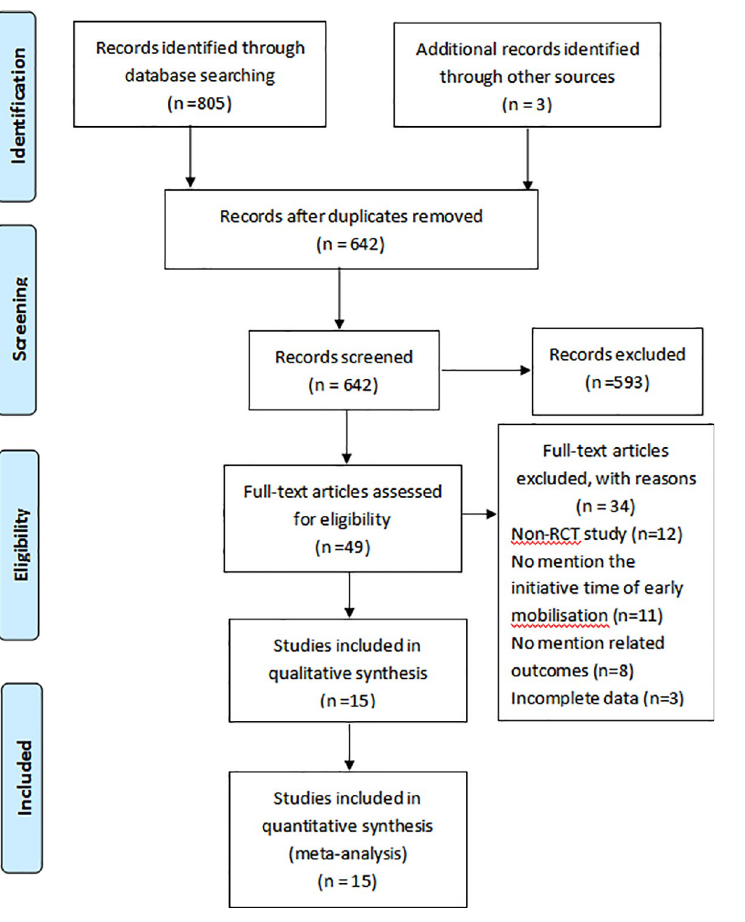
Fig 1. RCT: Randomized control